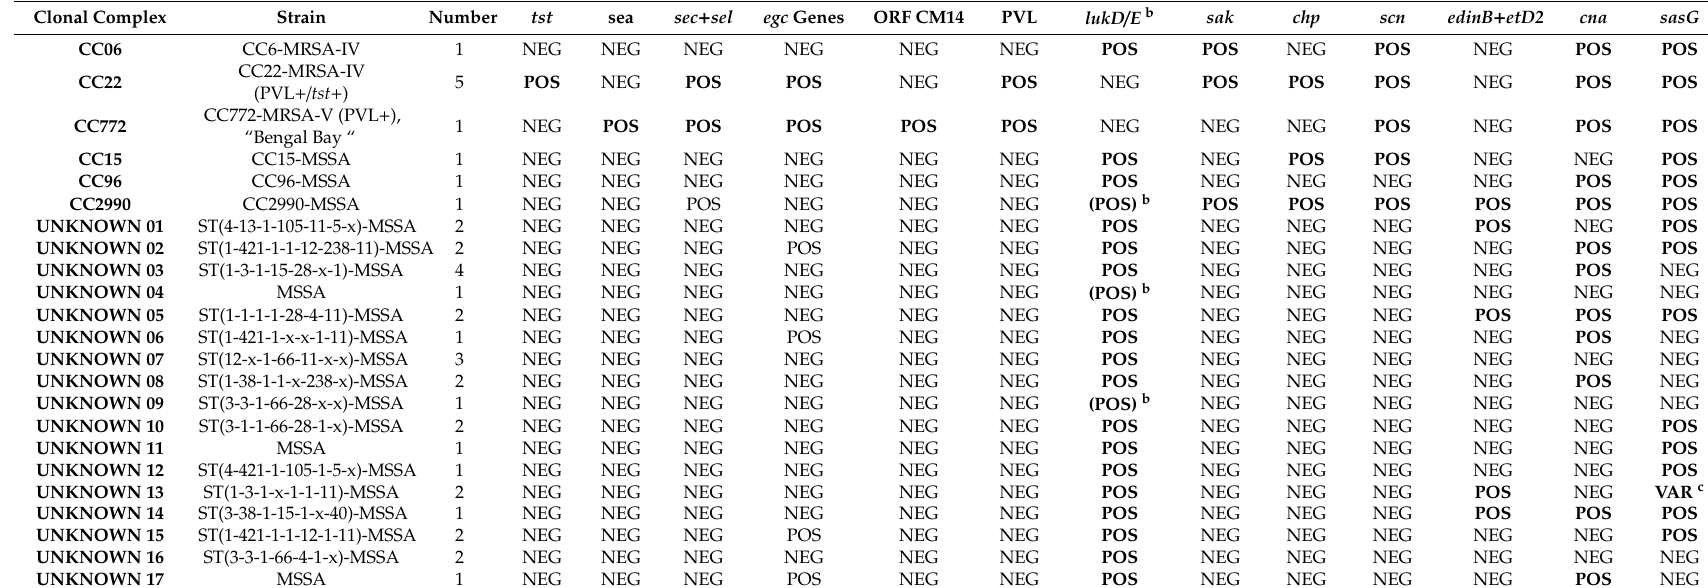
Table 4. Virulence-associated genes a